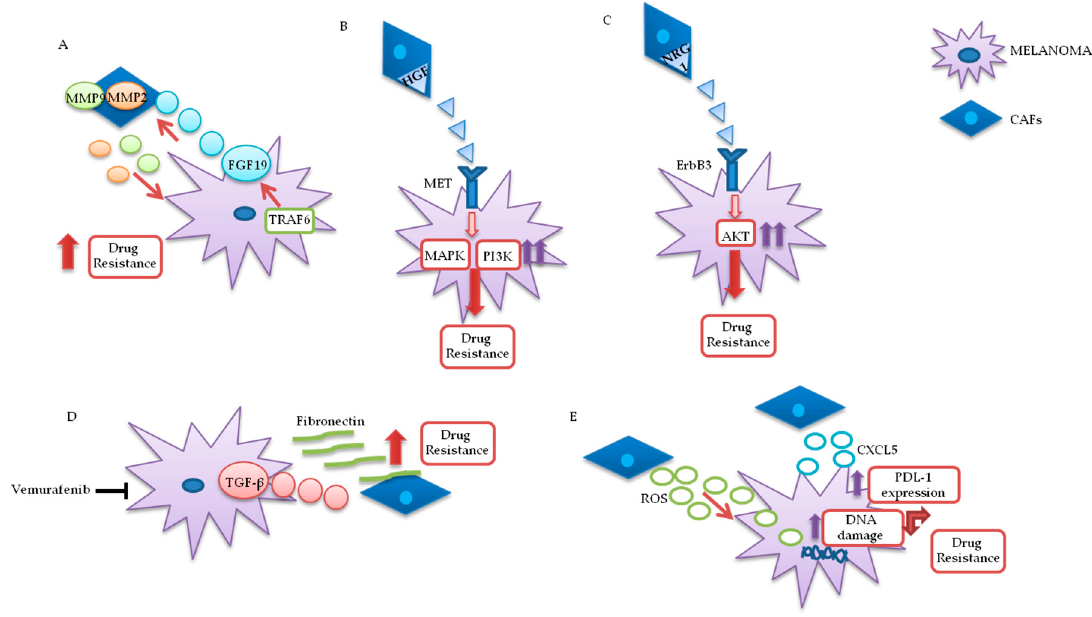
Figure 3. Melanoma/CAFs’ paracrine interconnections. ( A – E ) In this figure, is illustrated schematically the mutual interactions between melanoma cells and cancer-associated fibroblasts (CAFs). Several factors are implicated in these intricate interconnections at the basis of drugs resistance: Tumor necrosis factor receptor-associated factor 6 (TRAF6), fibroblast growth factor 19 (FGF19), metalloproteinases 2 and 9 (MMP2 and MMP9), hepatocyte growth factor (HGF), neuregulin 1 (NRG1), V-erb-b2 avian erythroblastic leukemia viral oncogene homolog3 (ErbB3), transforming growth factor β (TGF- β ), reactive oxygen species (ROS), CXC motif chemokine 5 (CXCL5), programmed death-ligand 1